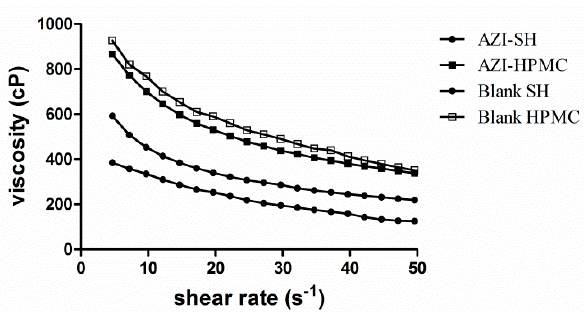
Figure 3. Comparison of the viscosity between AZI-SH formulation, AZI-HPMC formulation, blank SH and blank HPMC.